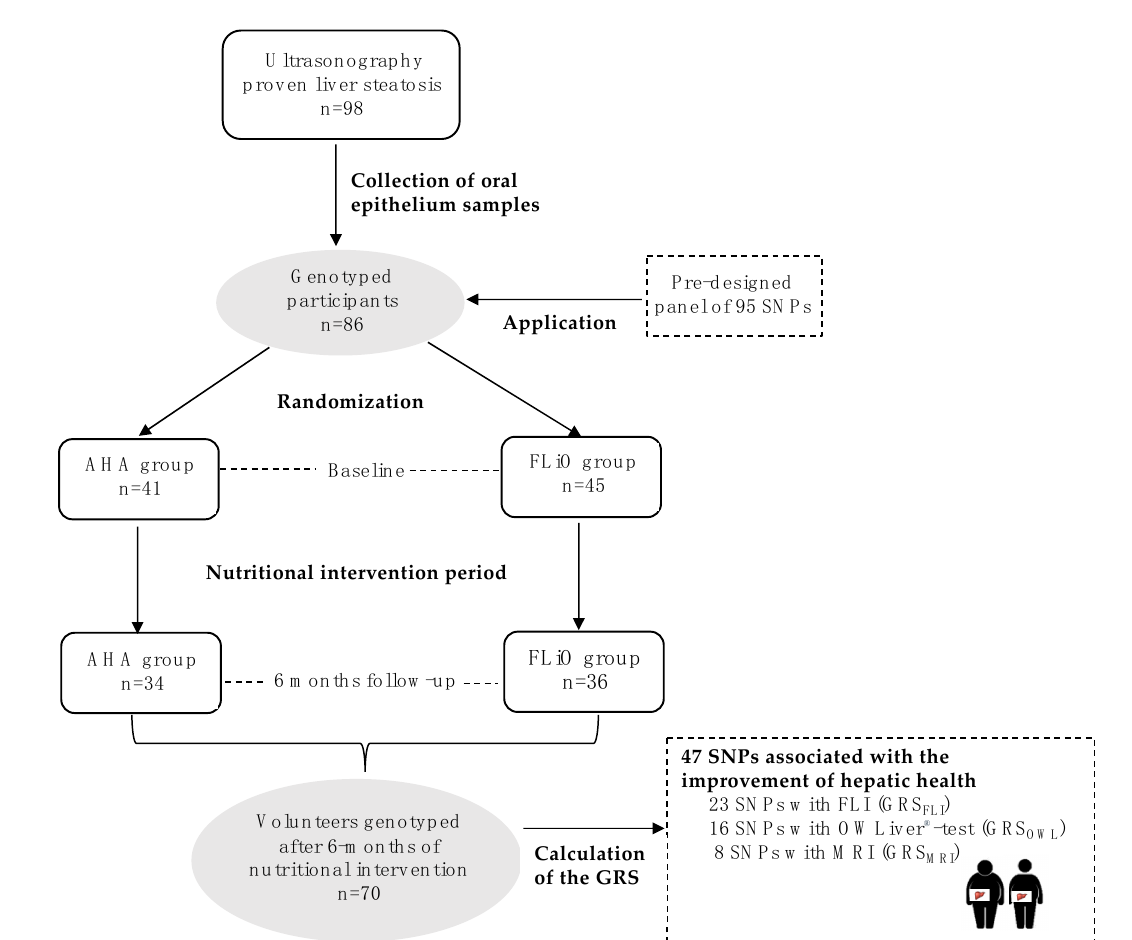
Figure 1. Design and flow chart of participants in the Fatty Liver in Obesity (FLiO) study. AHA, American Heart Association; FLI, fatty liver index; FLiO, Fatty Liver in Obesity; GRS, genetic risk score; GRSFLI, genetic risk score for FLI; GRSMRI, genetic risk score for magnetic resonance imaging; GRSOWL, genetic risk score for OWLiver ® -test; MRI, magnetic resonance imaging; SNPs, Single Nucleotide Polymorphisms.